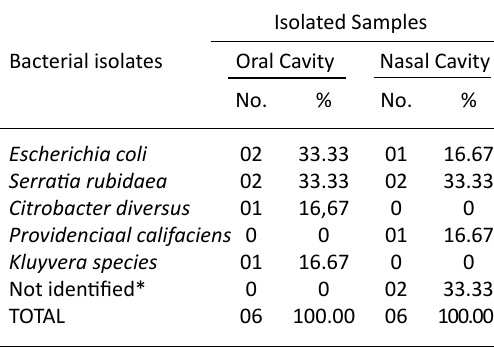
Table 1. Absolute (N) and relative (%) frequency of bacterial isolates belonging to the Enterobacteriaceae family among swabs of the oral and nasal cavity of horses used for animal traction in the municipality of Umuarama, Parana, Brazil, 2016 Isolated